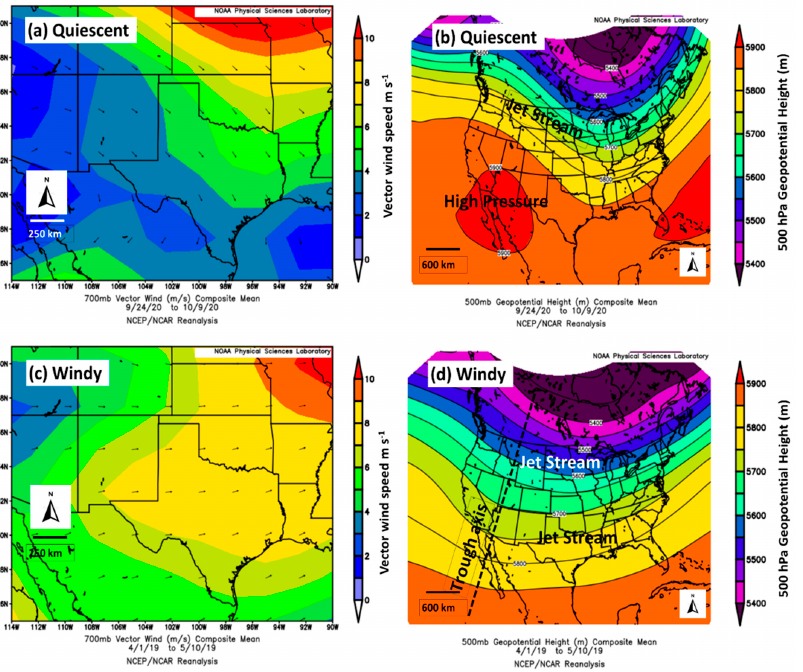
Figure 7. National Centers for Environmental Prediction (NCEP) NCEP/NCAR reanalysis of 700 hPa winds and 500 hPa geopotential heights for: ( a ) 700 hPa winds 24 September–9 October 2020 (quiescent); ( b ) 500 hPa geopotential heights from 24 September–9 October 2020 (quiescent); ( c ) 700 hPa winds 1 April–10 May 2019 (windy); and ( d ) 500 hPa geopotential heights 1 April–10 May 2019 (windy). Image composites were produced by the National Oceanic and Atmospheric Administration (NOAA) Physical Sciences Laboratory at their website https://www.psl.noaa.gov/data/composites/day/ (accessed on 14 February 2021).